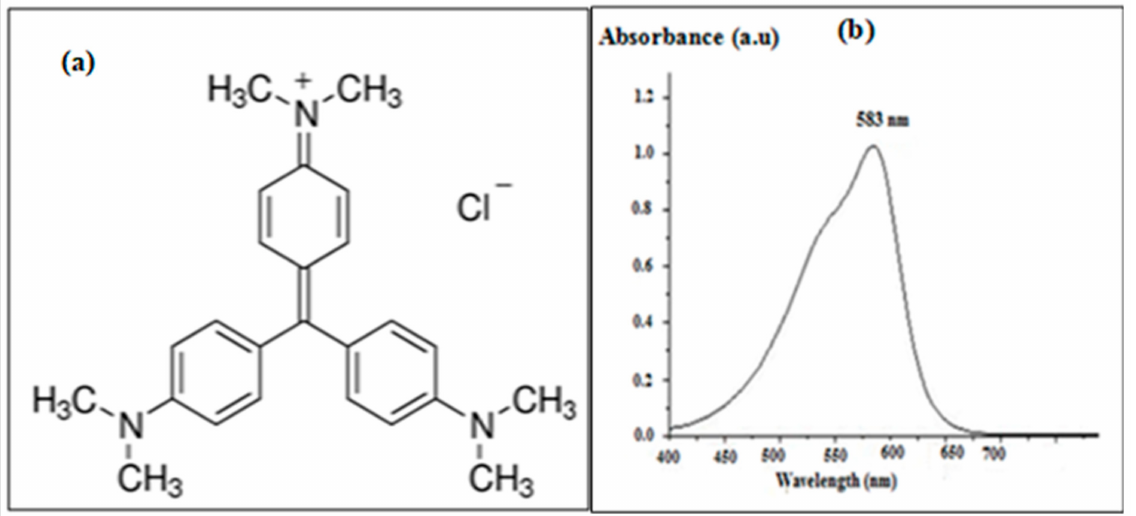
Figure 12. ( a ) Chemical structure and ( b ) UV visible spectra of CV